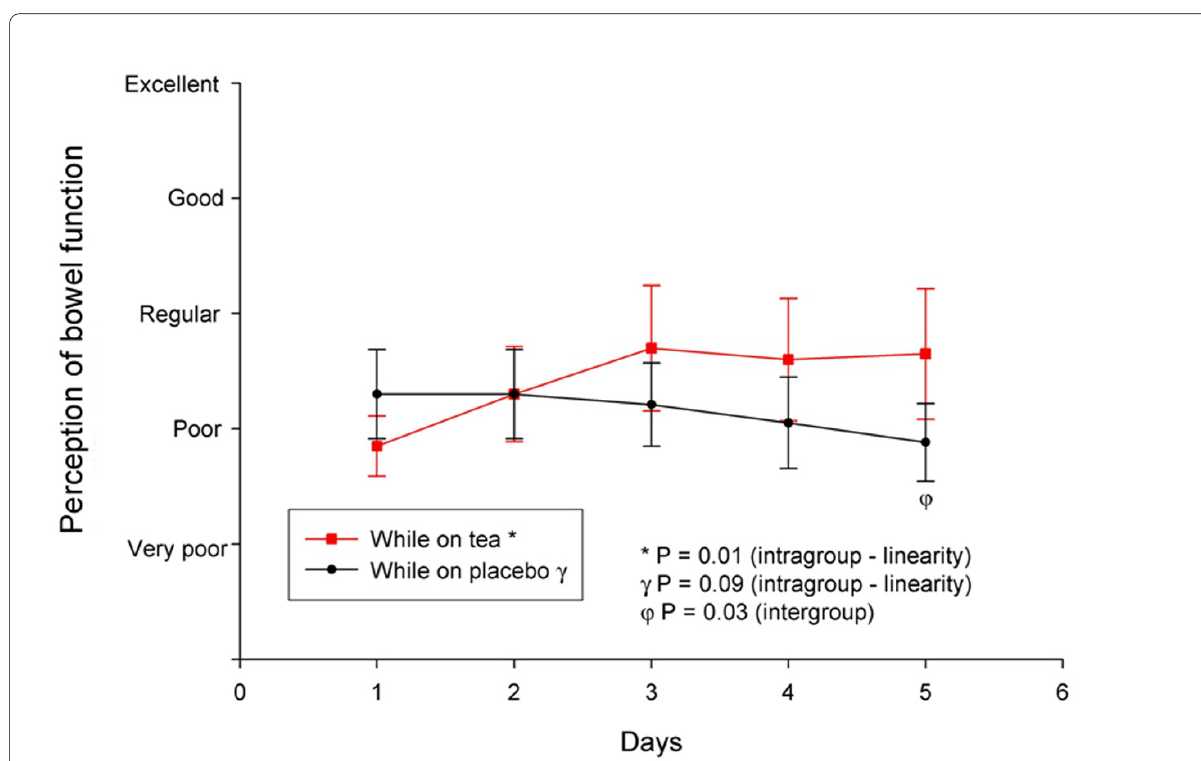
Figure 3 Bowel function perception by patients according to treatment period (active tea or placebo) . Values presented as means ± standard deviation.